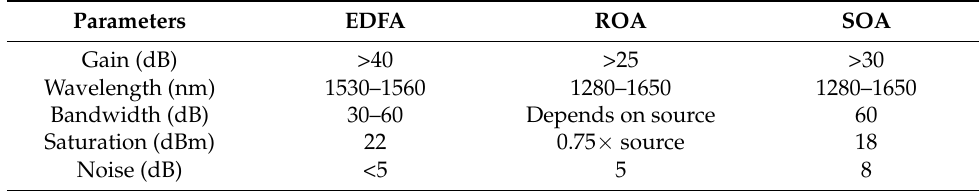
Table 1. Comparison of amplifier parameters.